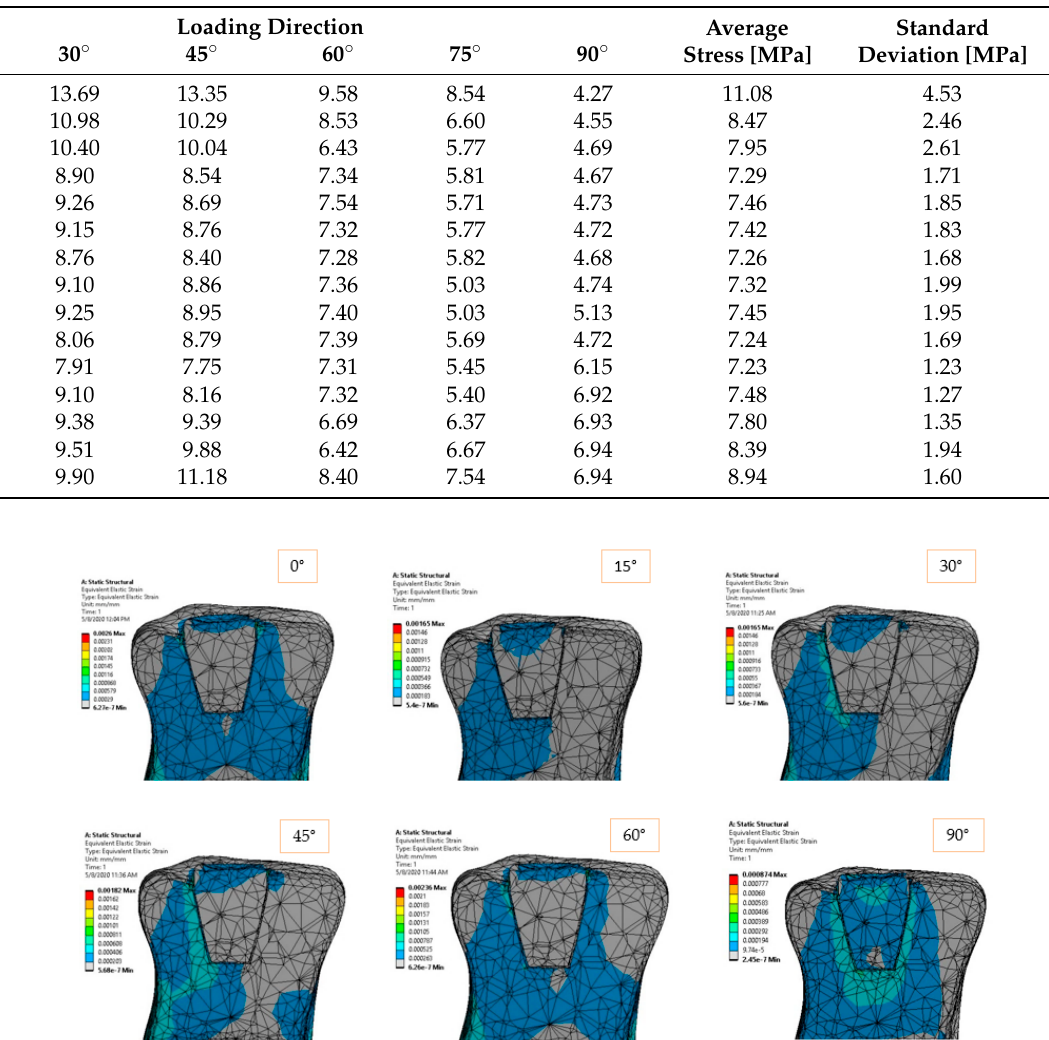
Table 5. Stress values in adhesive cement.